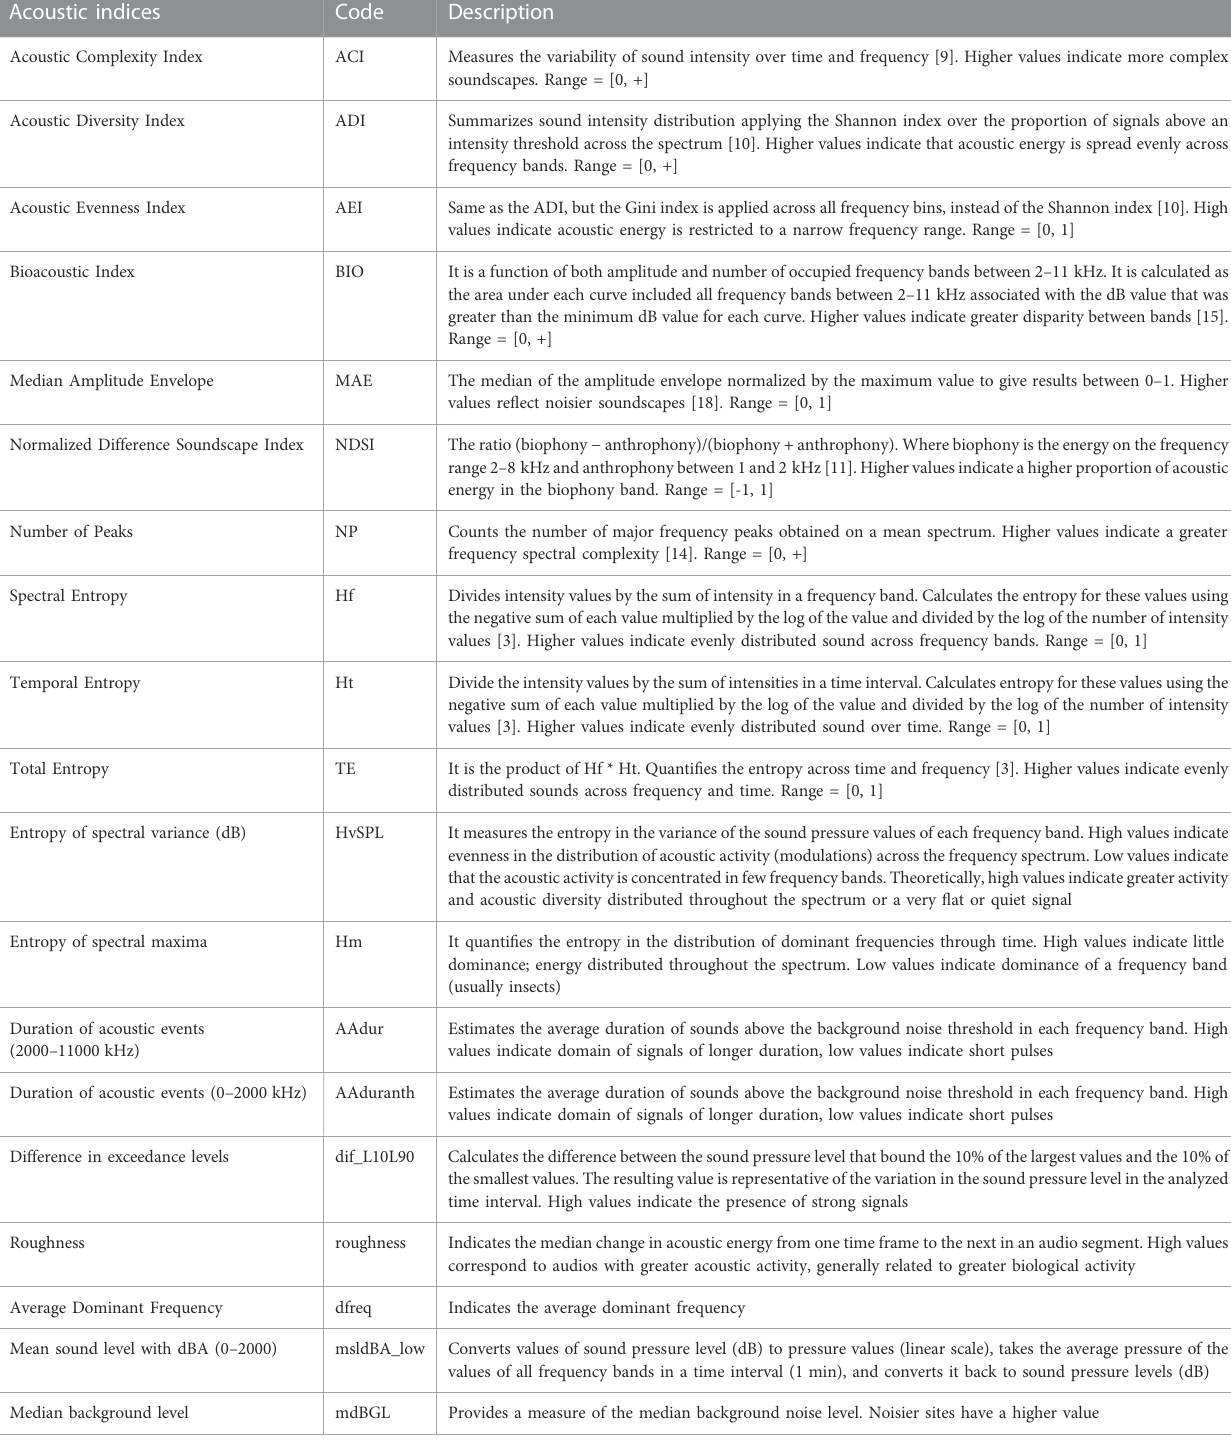
TABLE 3 Description of acoustic indices calculated for each sampling point in the Central Conservation Area of Costa Rica, 2019 –